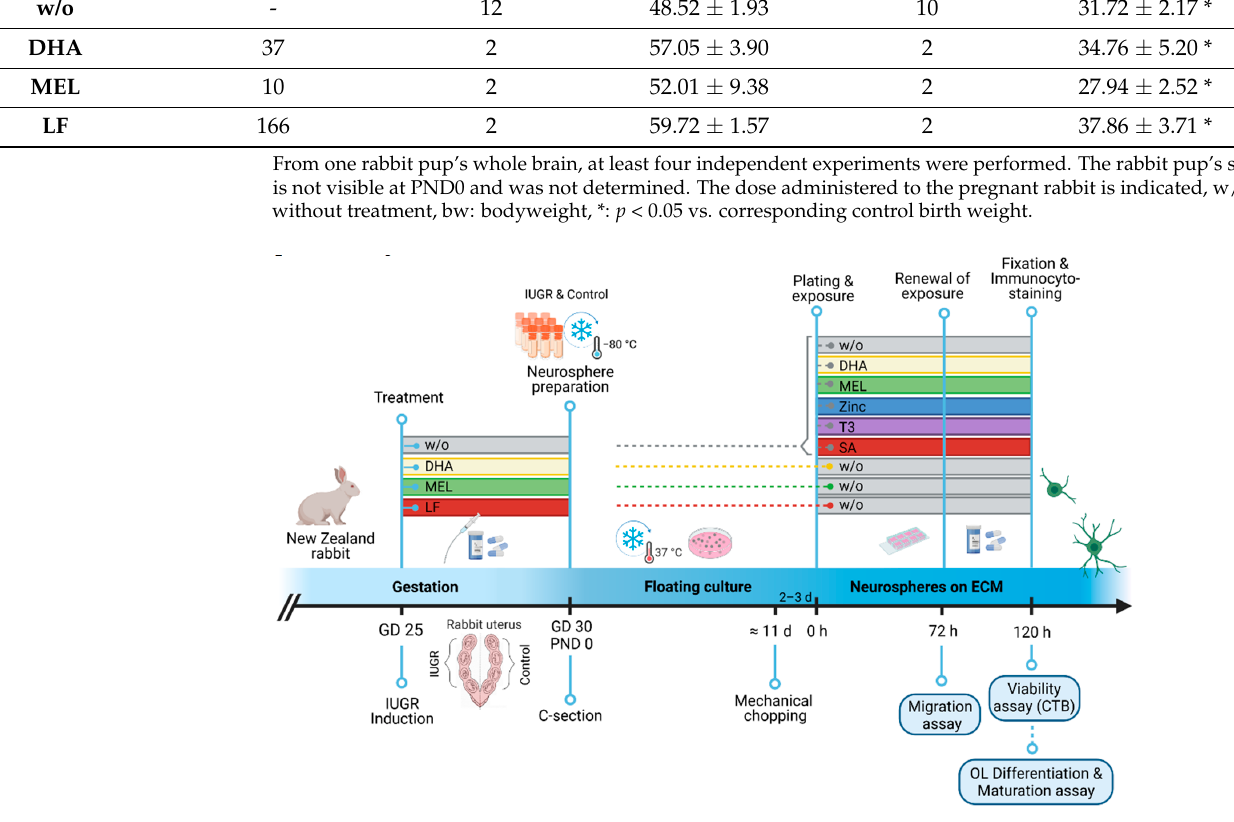
Figure 1. Experimental setup. IUGR was induced in one uterine horn of pregnant rabbits on gestational day (GD) 25, whereas the contralateral horn remained as control. No treatment (w/o) or ther- apies were administered to the pregnant rabbit until C-section (GD 30). On PND 0, IUGR and control pups were obtained from every group and neurospheres prepared from pup’s whole brain. Neuro- spheres were cultivated in a floating culture for approx. 11 days and mechanically chopped 2–3 days before plating. On the experimental day (0 h), neurospheres (0.3 mm) were plated on a PDL/Laminin coated eight-chamber slide w/o or with exposure to therapies. After 72 h migration distanced was measured and after 120 h viability, oligodendrocyte (OL) differentiation & maturation assessed. Rectangle bars = time of administration or exposure, blue circle = endpoints. w/o = without, GD = gestational day, PND = postnatal day, ECM = extracellular matrix, OL = oligodendrocyte, CTB = cell titer blue. Created with BioRender.com (accessed on 20 May 2022). 2.3.1. In Vitro Testing of Potential Therapies Therapies were dissolved in their corresponding solvent depending on their maxi- mum solubility (Table 2), and subsequently, in differentiation medium. Under differenti- ation conditions, NPCs were exposed for 5 days to the therapies and the exposure medium was renewed every 2–3 days. These 5 days of exposure were chosen because at this time- point, a significant difference of OL differentiation between control and IUGR cultures was previously detected [14], and because it is a time-point that makes it possible to ob- serve all maturation stages of O4+ cells. Basic processes of neurogenesis were assessed to determine the maximum tolerated concentration (MTC) and most effective concentration (EC). The criteria to define the MTC was a viability >70% of solvent control (SC) values, a not significantly reduced migration distance, or a not significantly reduced OL percentage compared to the SC.